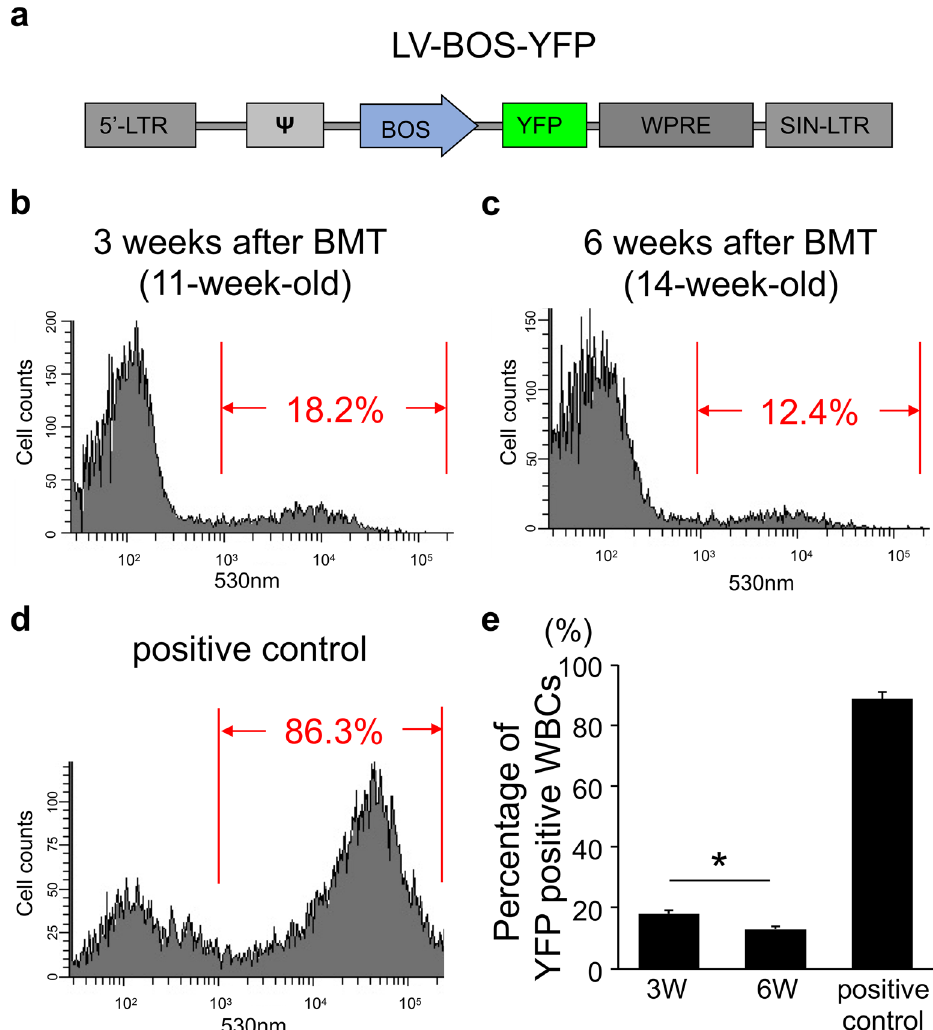
Figure 1. Transduction efficiency of bone marrow cells with LV-BOS-YFP in wild type mice. ( a ) Schematic representation of LV-BOS-YFP. ( b–d ) Representative flow cytometric analysis of peripheral white blood cells with YFP signals after gene transduction by LV-BOS-YFP in wild type mice at 3 weeks [( b ), 11-week-old] and 6 weeks [( c ), 14-week-old] after bone marrow transplantation. ( d ) Representative flow cytometric analysis of peripheral white blood cells in recipient mice after bone marrow transplantation from GFP transgenic mice as a positive control. ( e ) The percentage of YFP positive WBCs in total peripheral WBCs of 3 weeks and 6 weeks after bone marrow transplantation groups and positive control group (n = 3, each group). Red letters indicate the YFP-positive population in ( b–d ). Error bars represent the mean + SD. *p < 0.05. LTR long terminal repeat, packaging signal, WPRE woodchuck hepatitis virus posttranscriptional regulatory element, SIN self- inactivating, WBCs white blood ϕ